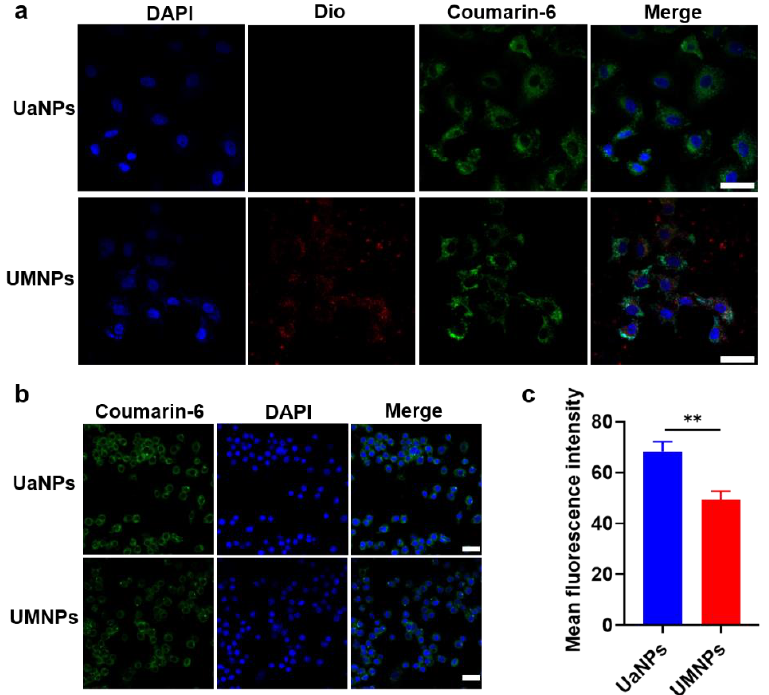
Figure 2. Confocal images of cellular uptake of UaNPs and UMNPs with ( a ) A549 cells and ( b ) ( b ) RAW264.7 cells. Scale bar = 20 µ m. ( c ) Quantitative analysis of fluorescence intensity. Scale RAW264.7 cells. Scale bar = 20 μm. ( c ) Quantitative analysis of fluorescence intensity. Scale bar = 20 μm. "Differences were considered significant when ** p < 0.01. bar = 20 µ m. Differences were considered significant when ** p <